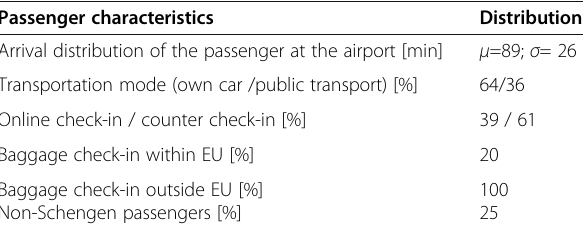
Table 1 Overview of the different passenger characteristics used for the simulation